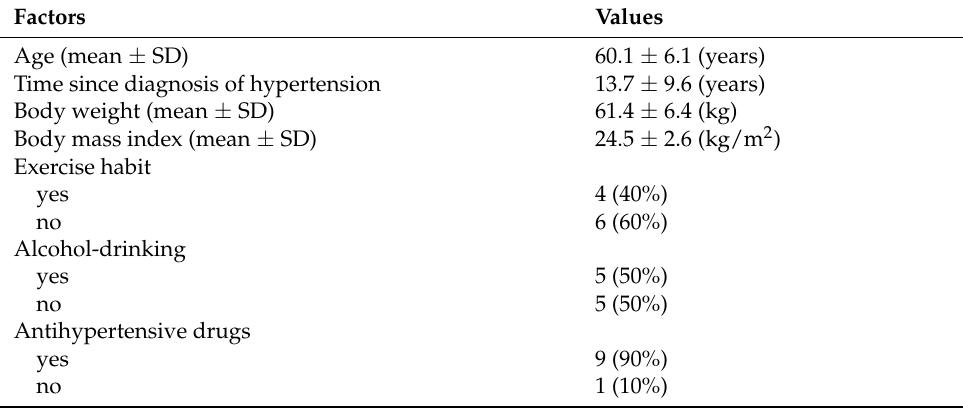
Table 2. Characteristics of the participants ( n = 10).